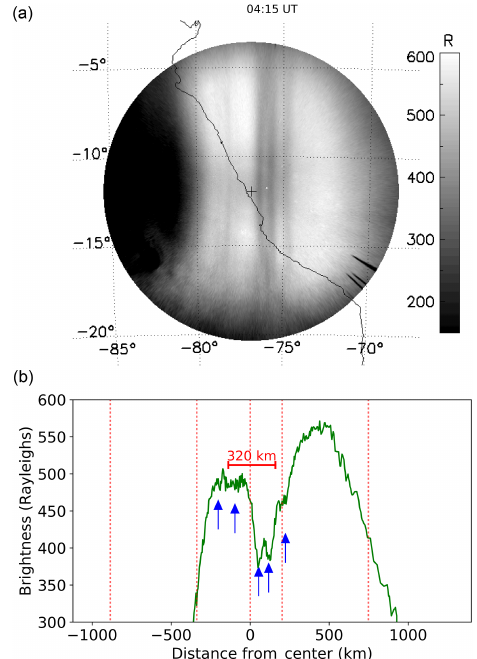
Figure 6. An example from 3 April 2014 of how depletion sepa- ration is measured. Panel (a) is an unwarped ASI image with two groups of depletions visible. Panel (b) shows brightness at a line of constant latitude that passes through zenith. The red dotted lines show the four lines of longitude from the image and the center of the image where the ASI is located. The blue arrows show the loca- tions of the depletions. The distance between the depletion groups is shown in red at the top of the image. The center of these groups are marked by the edges of the red